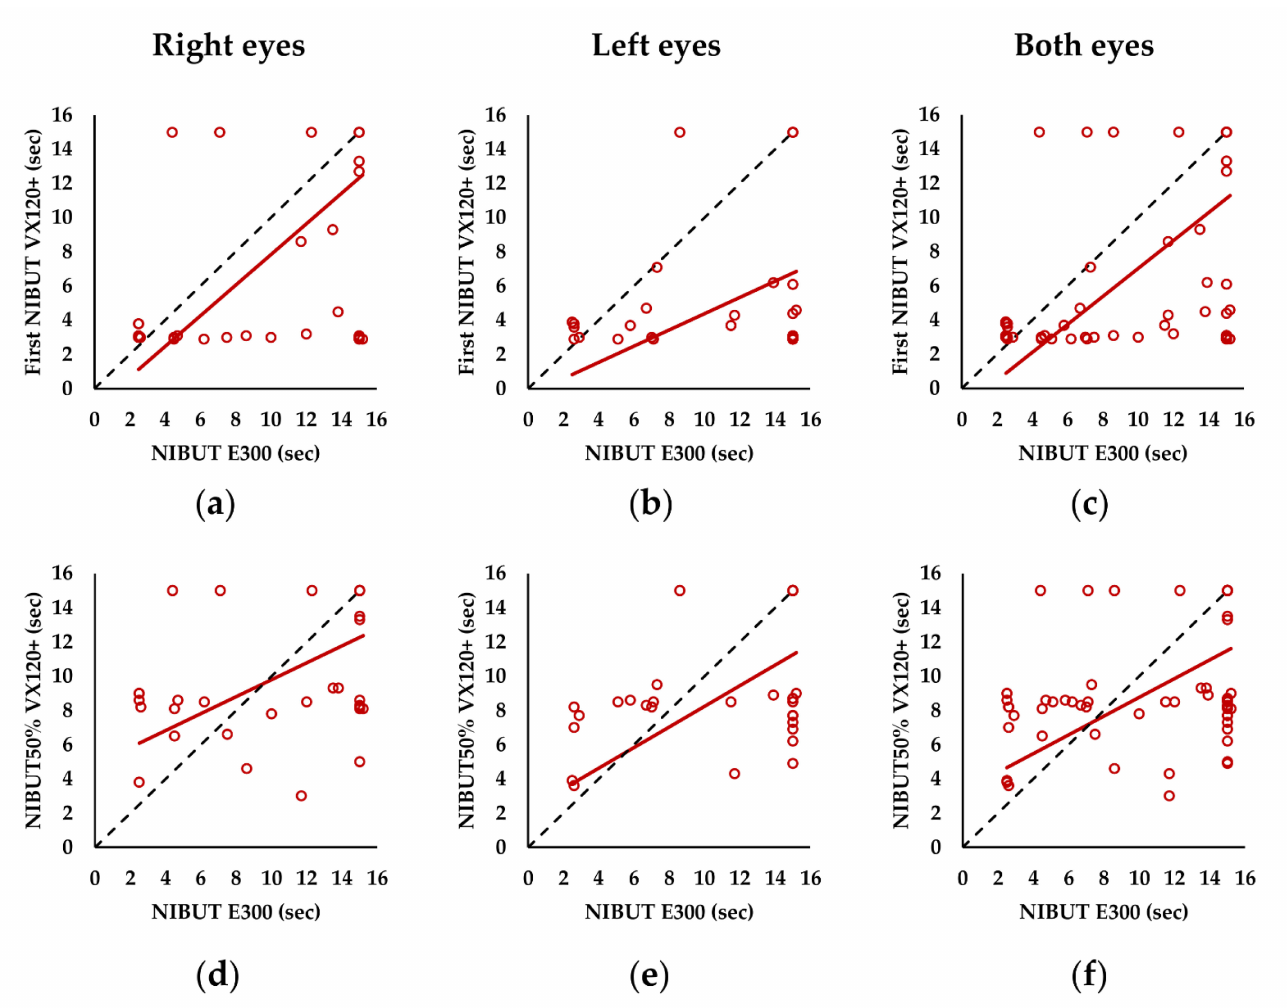
Figure 2. Passing–Bablok regression analyses for the agreement of the non-invasive tear break-up time (NIBUT) obtained from Medmont E300 and Visionix VX120+ devices comparing: ( a ) first NIBUT VX120+ and NIBUT E300 for right eyes, ( b ) left eyes, and ( c ) both eyes; and ( d ) NIBUT50% VX120+ and NIBUT E300 for right eyes, ( e ) left eyes, and ( f ) both